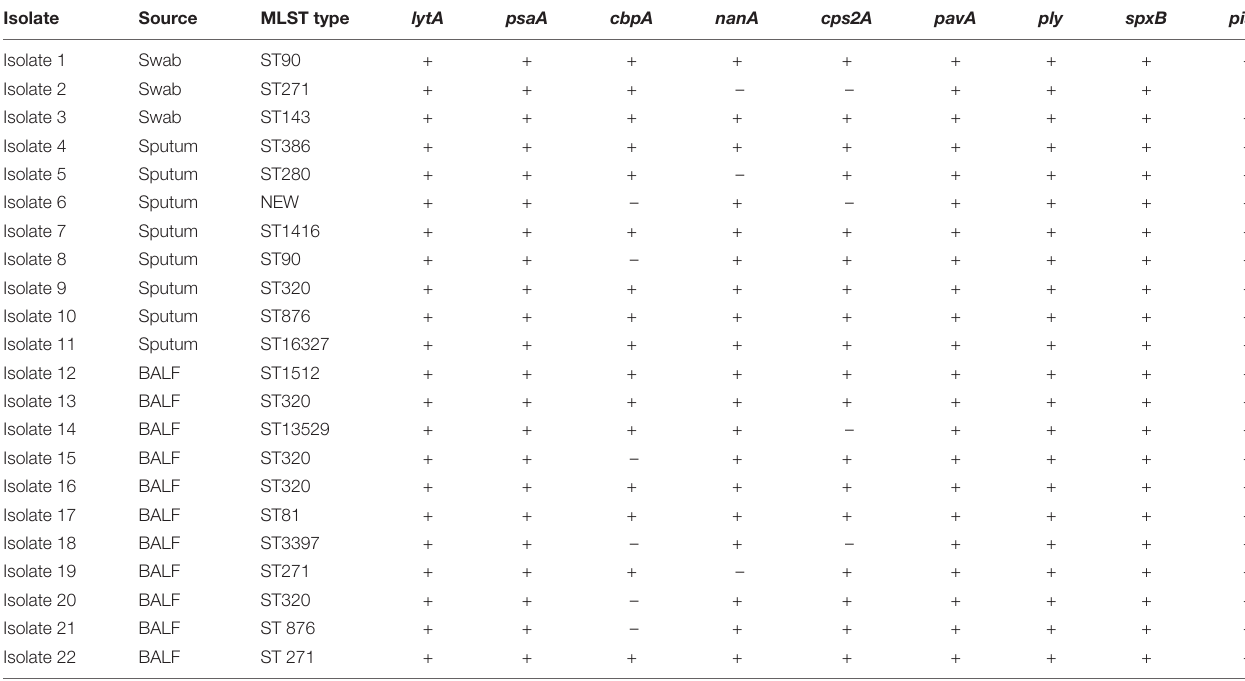
TABLE 3 | Characteristics of Streptococcus pneumoniae